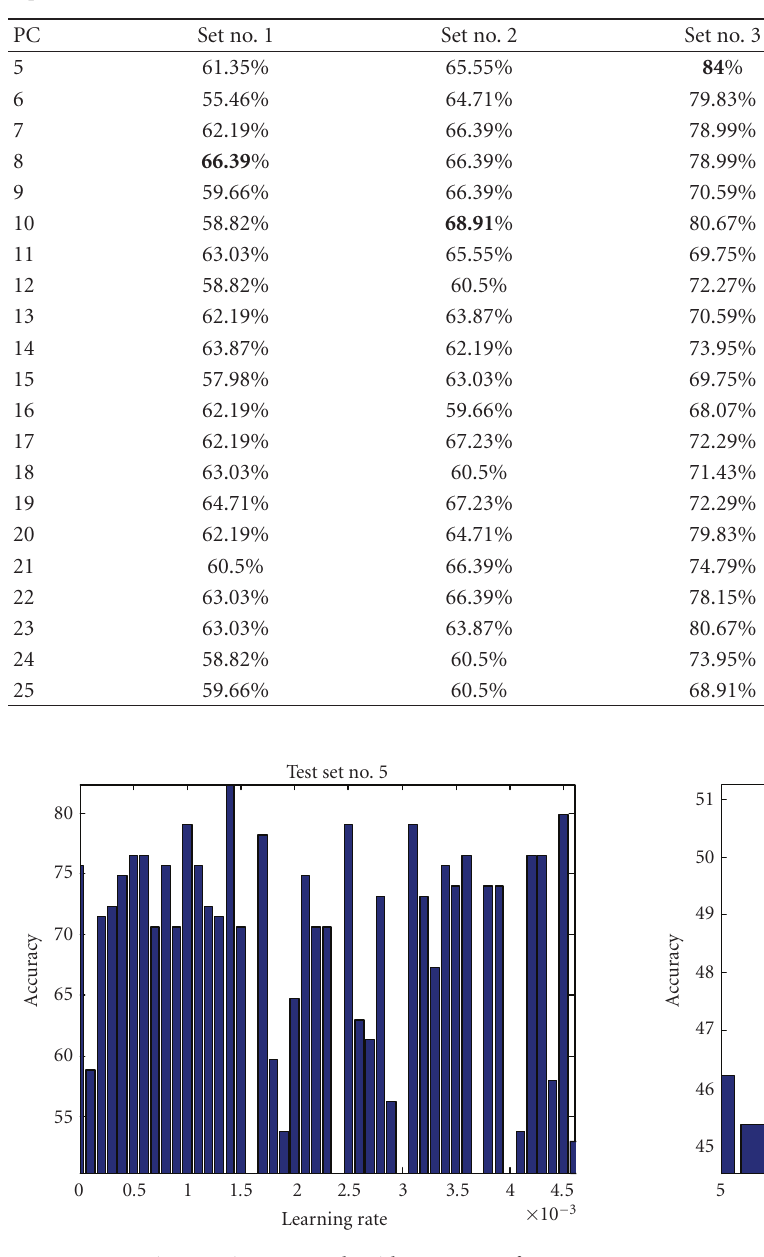
Table 4: Number of selected principal components impact on algorithm accuracy where learning rate and mapping range of each set are kept fixed.